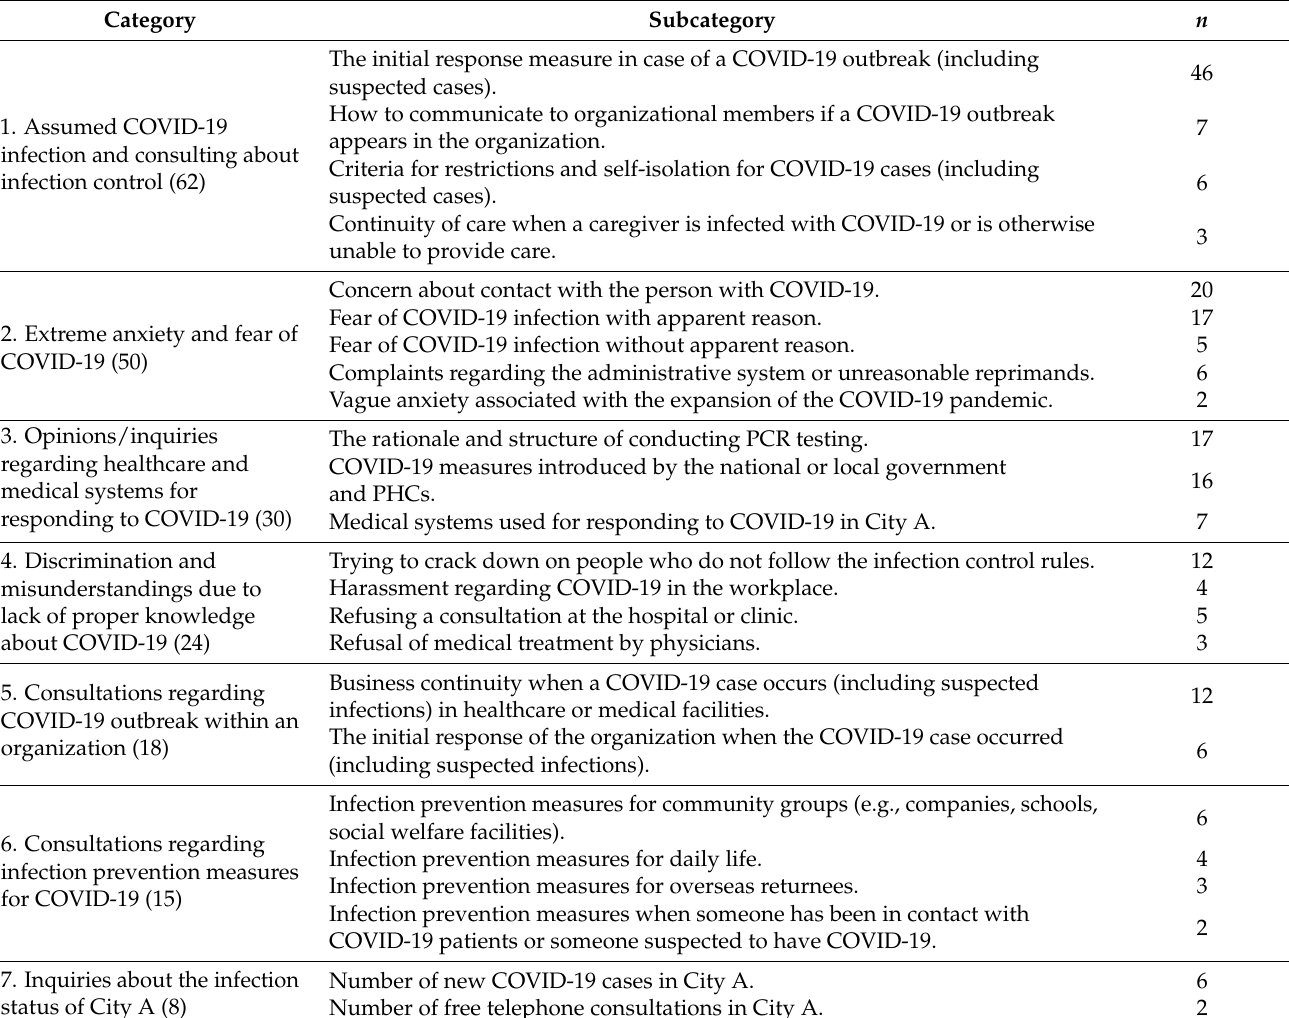
Table 2. Categories of the 207 “other” consultation